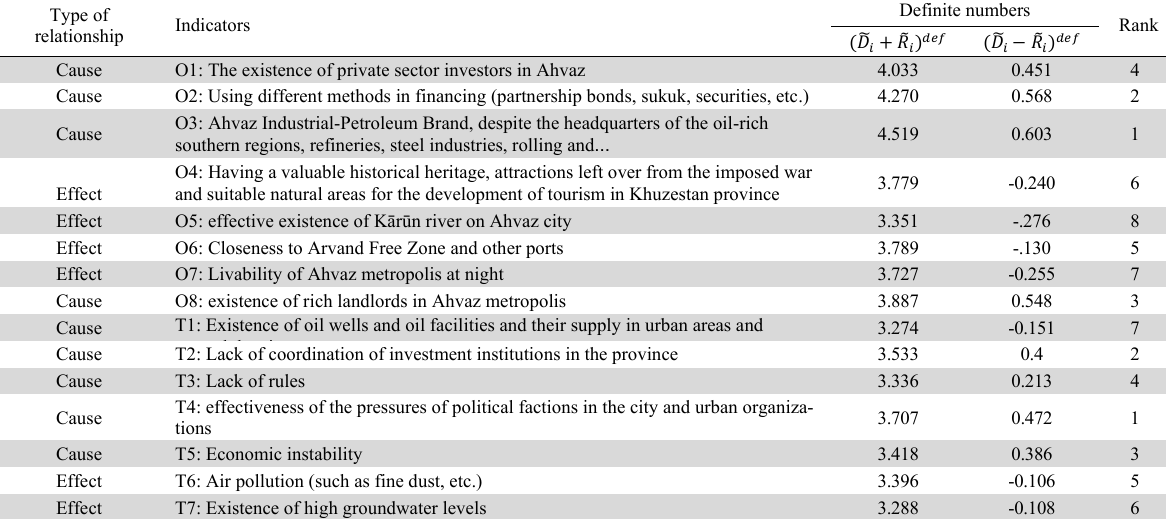
Significance and effectiveness of criteria of external environment indicators in SWOT matrix Type of